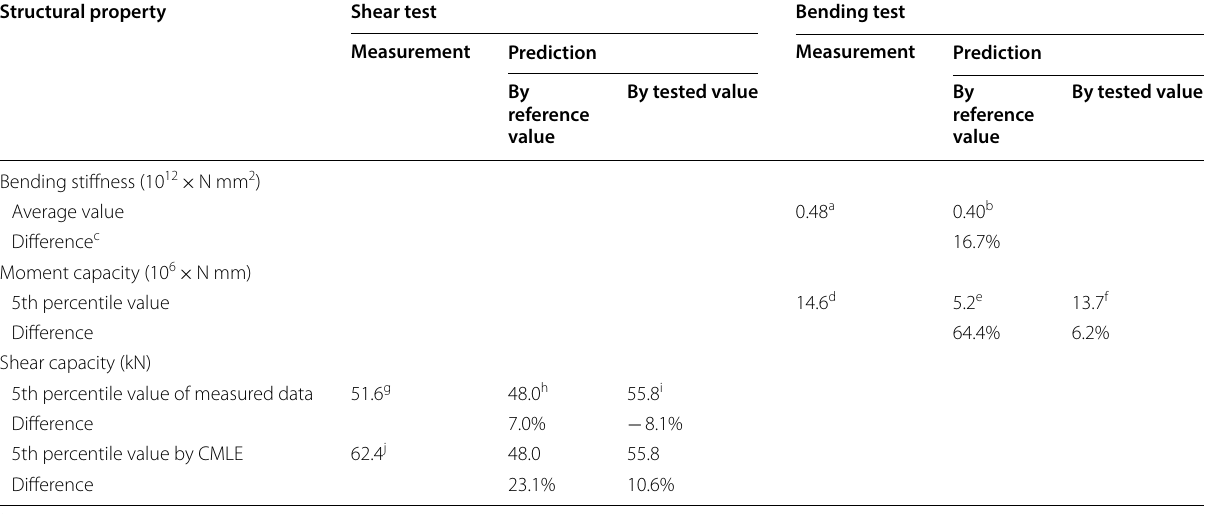
a Average value of experimental data measured by Eq. 2 b Predicted value by transformed section of Ply-lam from Eq. 3 c